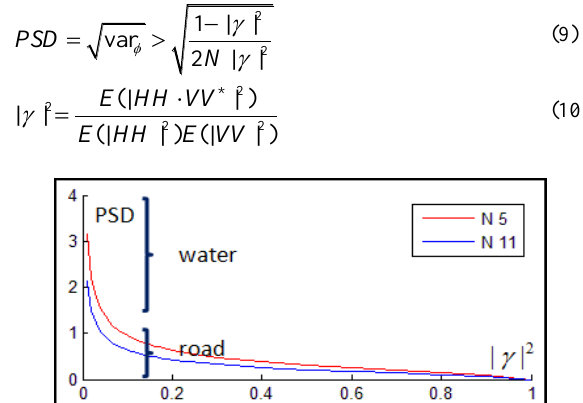
Figure 7. The relation between PSD and correlation